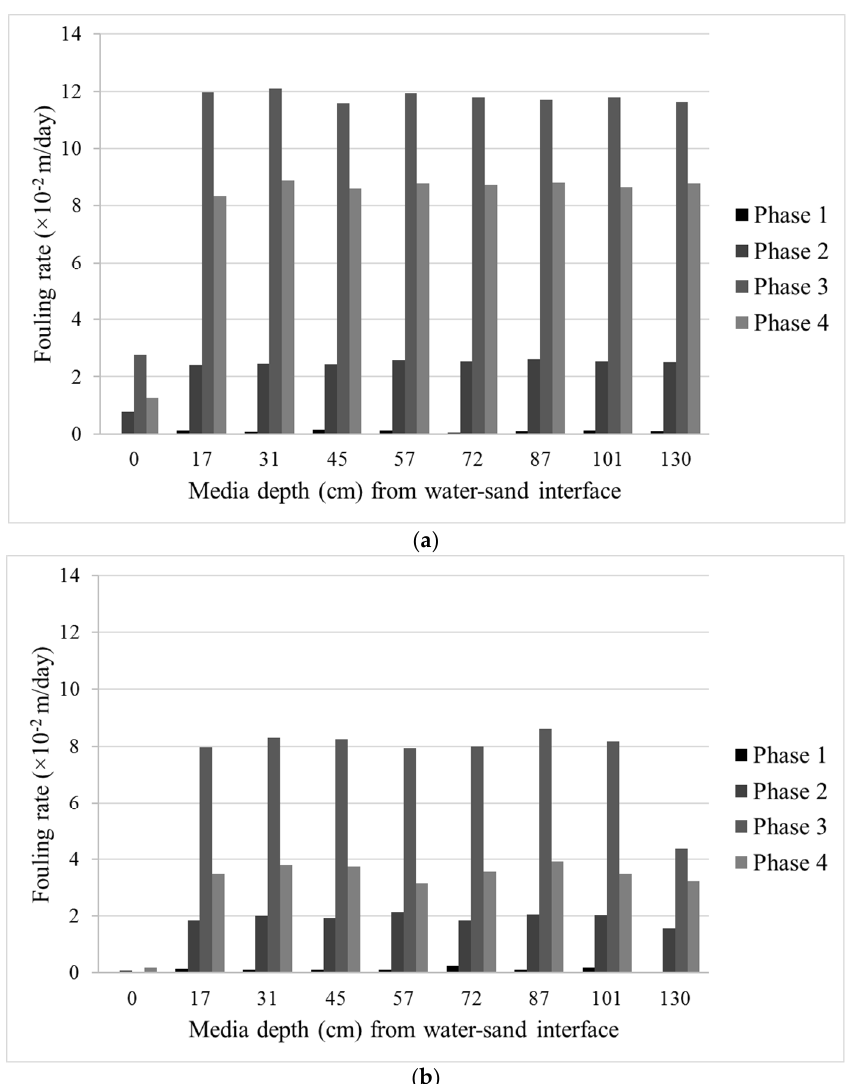
Figure 8. Fouling rates of ( a ) Column 1 and ( b ) Column 2 calculated from the Lindquist